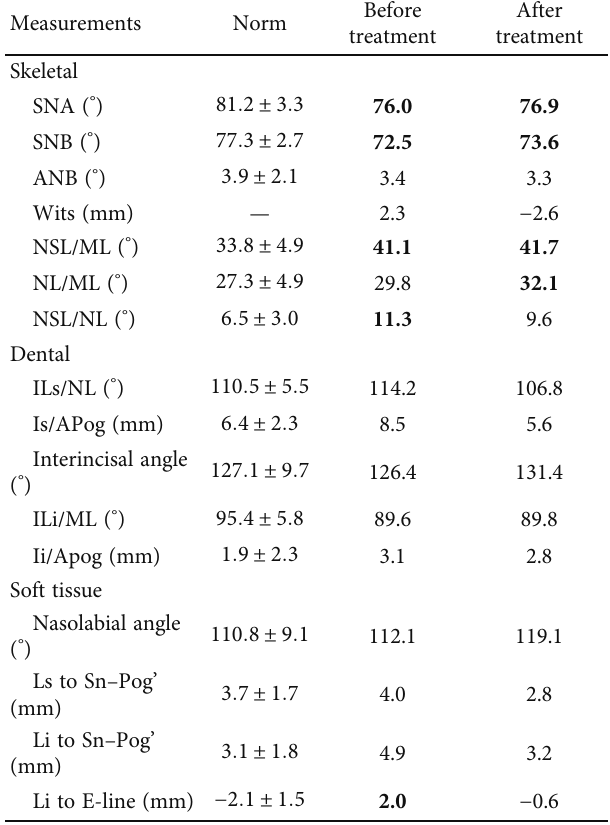
Table 1: Cephalometric measurements before and after treatment.